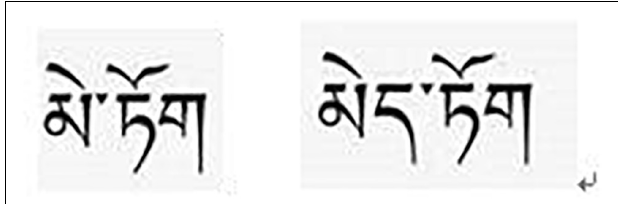
FIGURE 1 | An example of a word and a non-word in Tibetan, meaning “flower” (the left is a word and the right is a